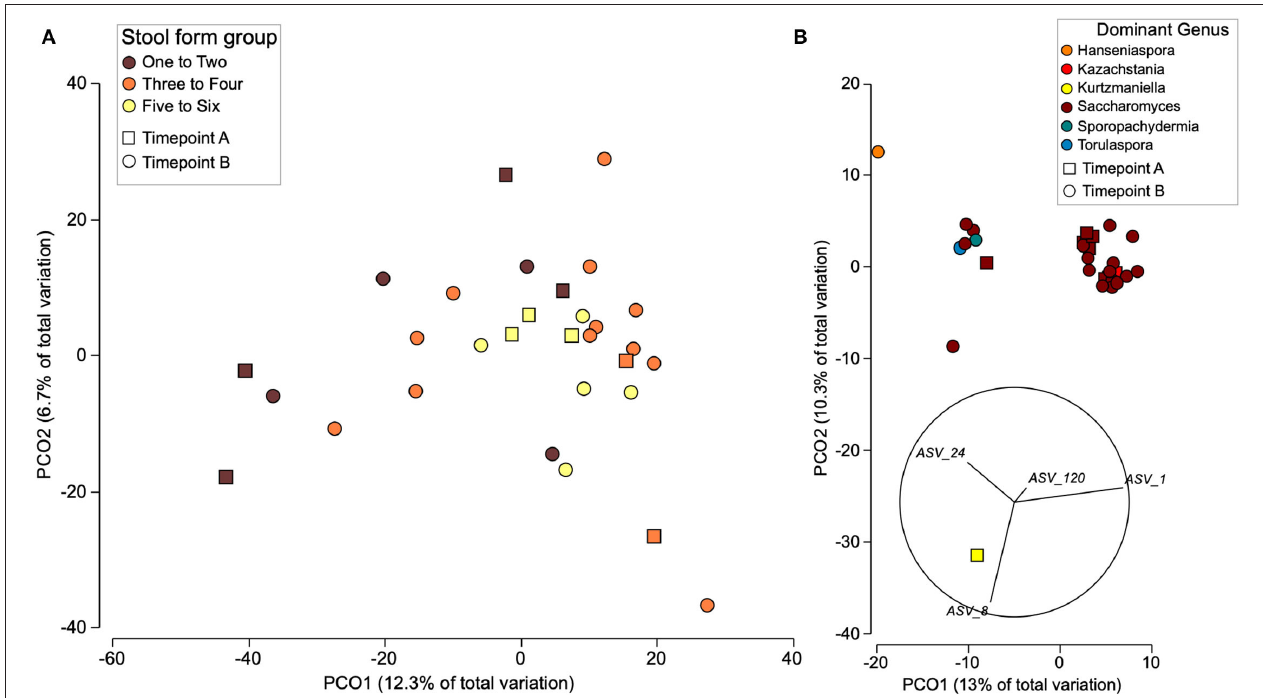
FIGURE 1 | Beta diversity of bacterial (A) and fungal (B) communities from all individuals at both time points using PCoA. (A) Distribution of the bacterial communities is shown due to stool form and timepoint. (B) Fungal communities are displayed based on dominant taxa and timepoint with abundant ASVs plotted as vectors. Beta diversity was estimated from Euclidian distances between CLR transformed